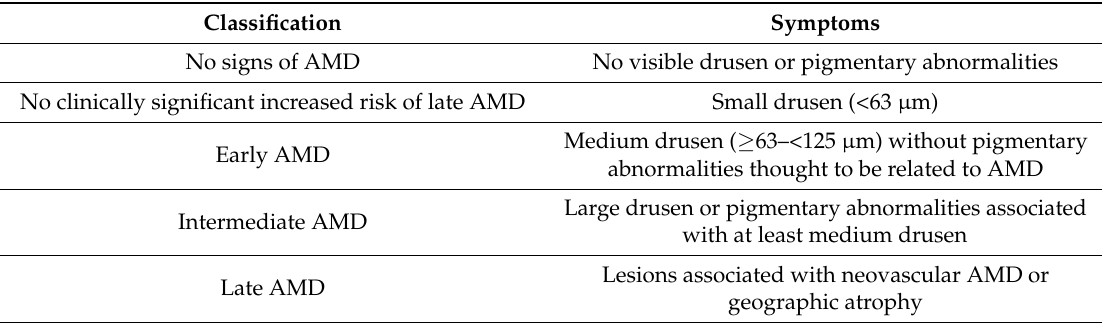
Table 1. Clinical classification scale for age-related macular degeneration